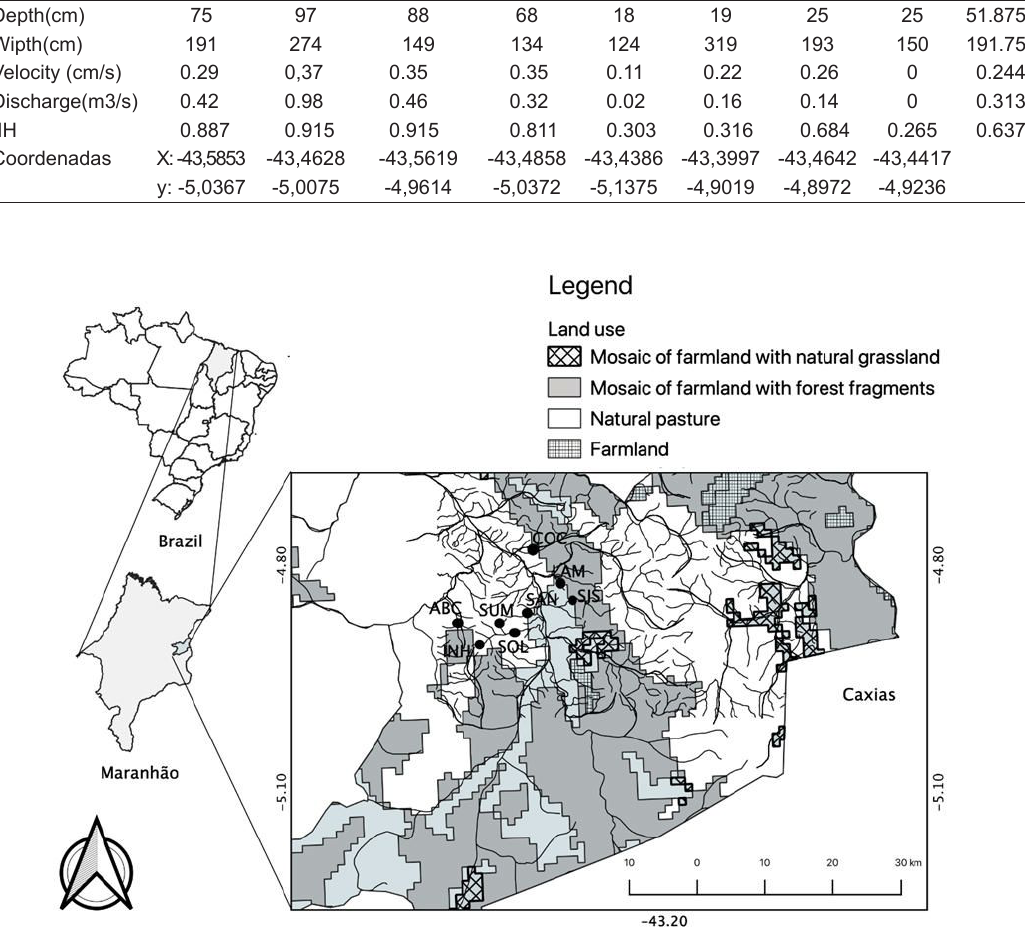
Table 1. Odonate species collected in the streams sampled in the municipality of Caxias, Maranhão (Brazil). Riachos Inhamum Soledade Sumidouro